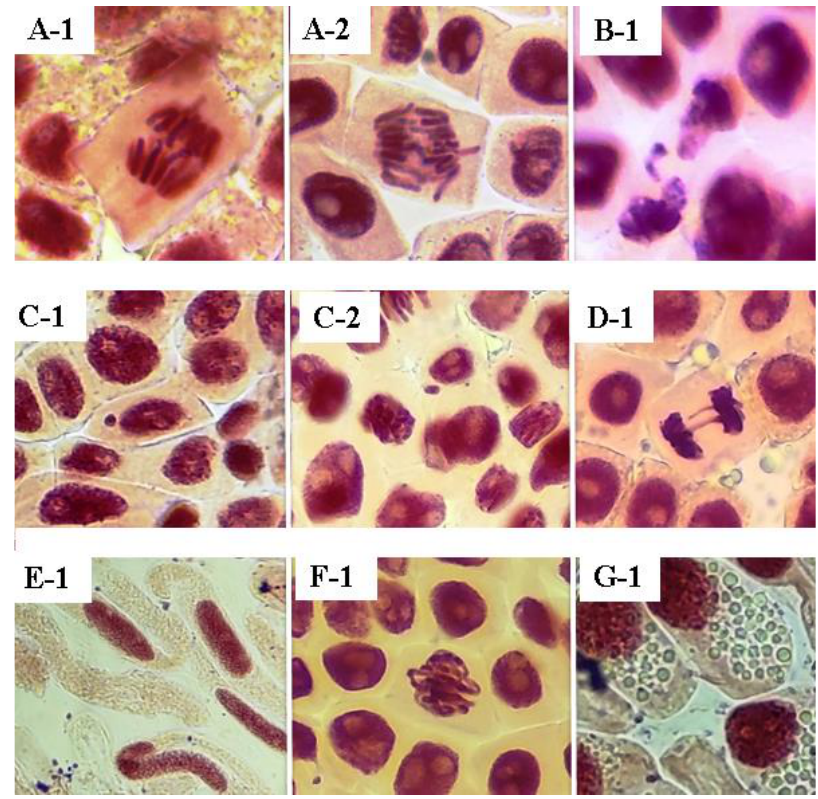
Figure 5. Chromosomal aberrations caused by the extract from A. muricata seeds. Source: Author, 2022. ( A-1 – 2 ): Wandering chromosomes; ( B-1 ): chromosomal loss; ( C-1 – 2 ): micronuclei; ( D-1 ): telophase bridge; ( E-1 ): shape changes; ( F-1 ): viscosity; ( G-1 ): necrosis—detected by the presence of vacuoles in the cytoplasm.